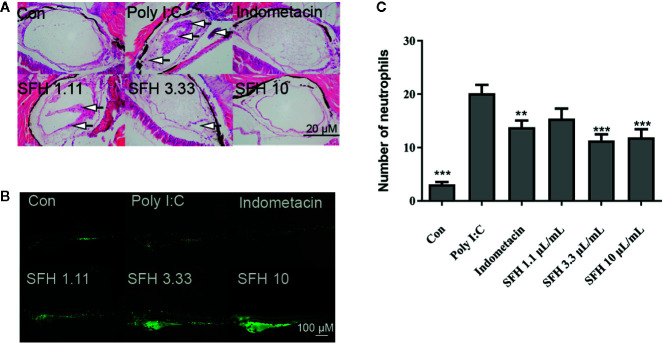
Effect of SFH on Poly (I:C)-induced pneumonia. (A) HE staining to observe the pathological features. Arrows mark the inflammatory infiltration and cell shedding. (B) Fluorescence detection on neutrophils. (C) The numbers of neutrophils in air bladder tissue are counted. For all experiments, at least 30 larvae were used for each condition. ** indicated significant difference at p < 0.01, *** indicated significant difference at p < 0.001, compared with Poly (I:C) group.